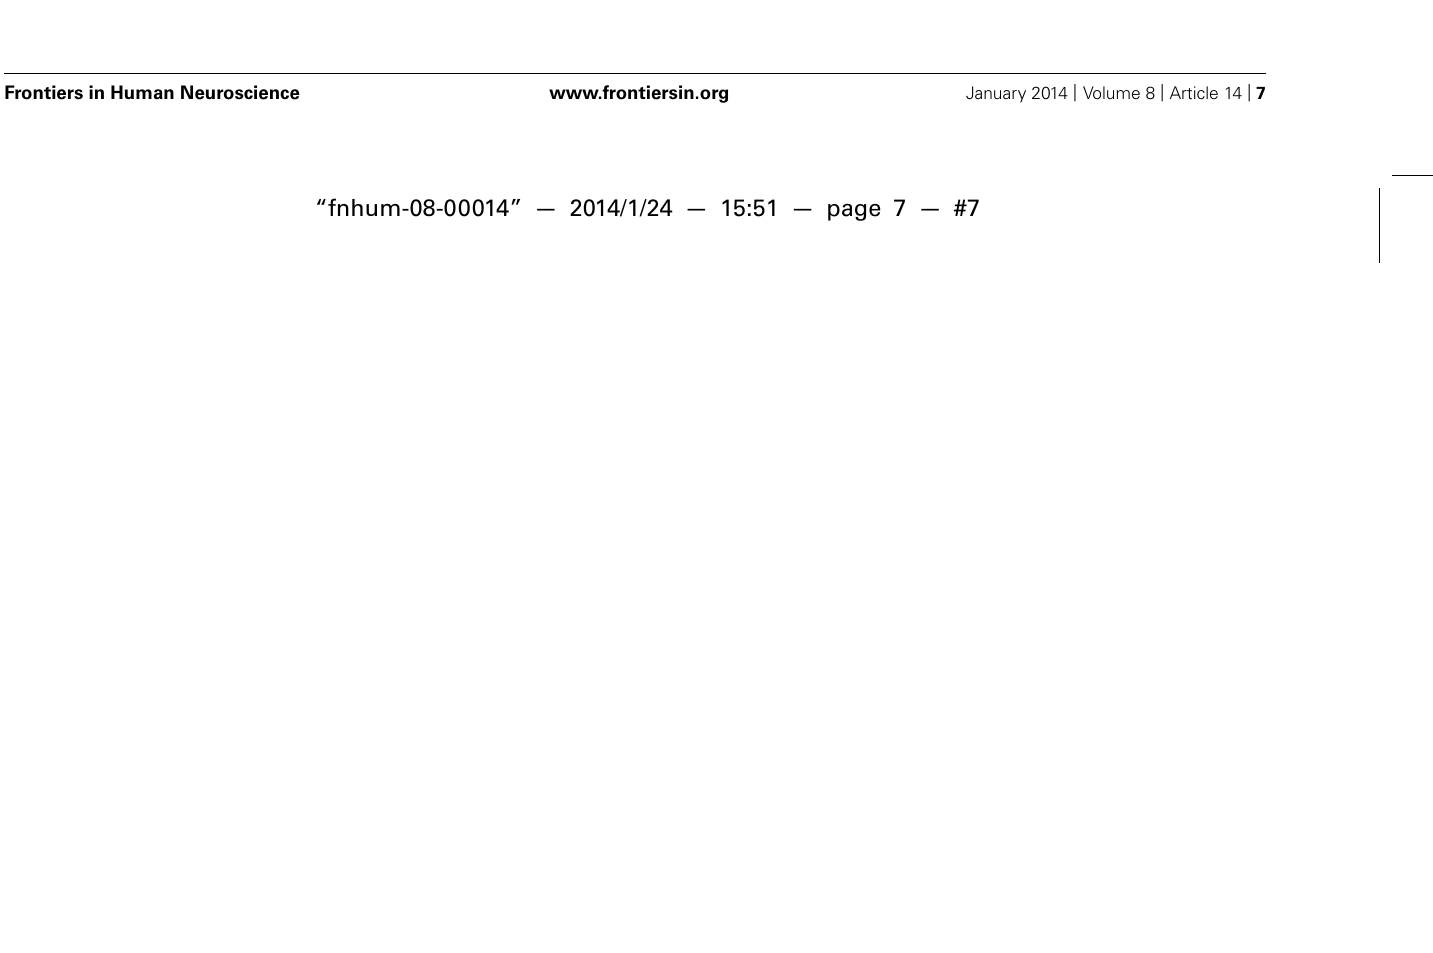
FIGURE 3 | Brain areas significantly more activated in the Uncertainty > Certainty and Certainty > Uncertainty contrasts ( p < 0.0005, uncorrected, min. 20